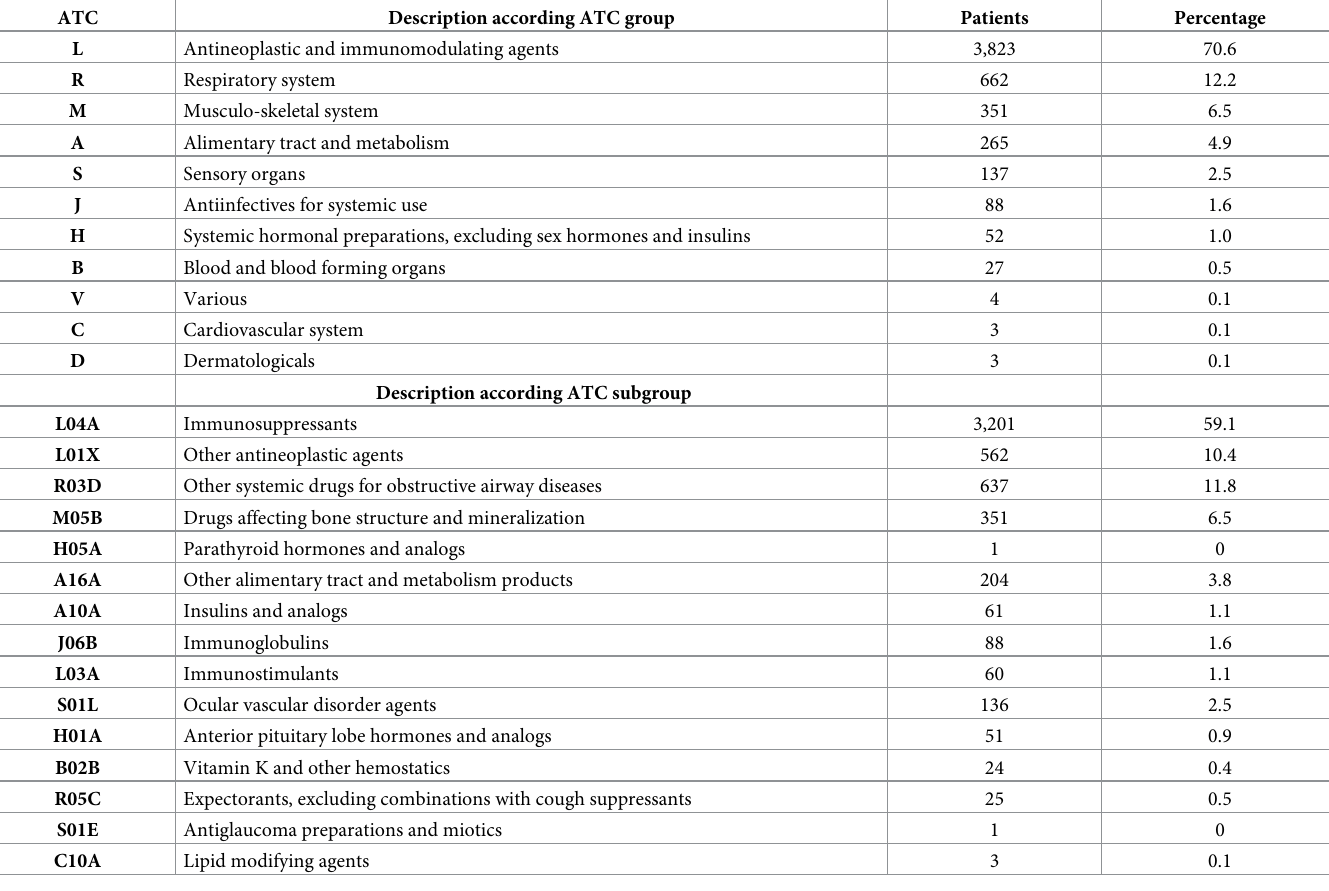
Table 2. Classification of biological agents associated with adverse drug reactions according to the Anatomical Therapeutic Chemical (ATC) group and subgroup in Colombia from